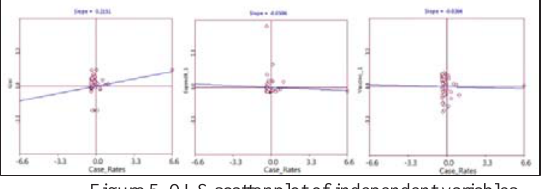
Figure 5. OLS scatter plot of independent variables. Gini vs. case rate (left), expenditure vs. case rate (middle), vaccine rate vs. case rate (right)